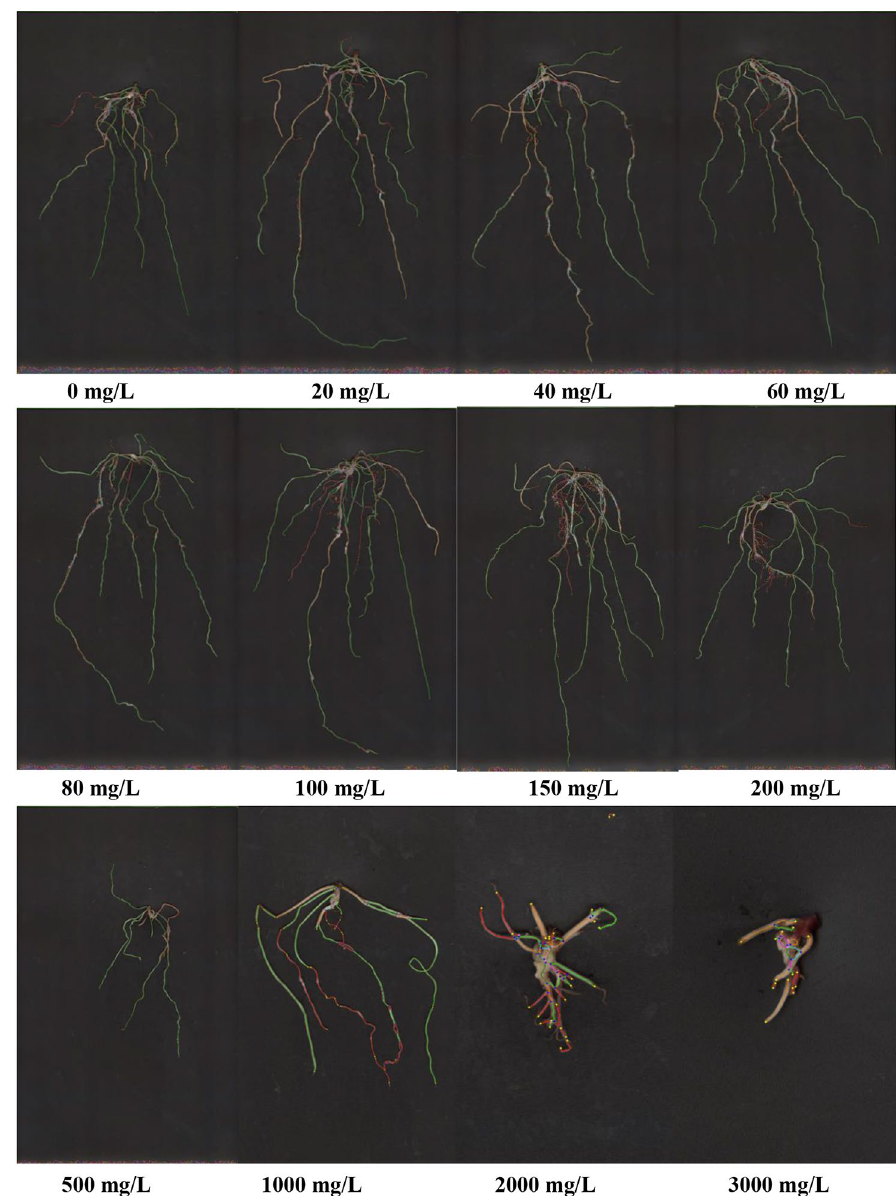
Fig. 5 Root structure of the